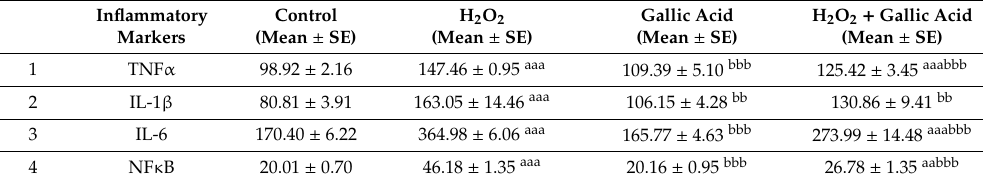
Table 3. E ff ects of gallic acid on inflammatory markers of rat’s embryonic fibroblast cells. Inflammatory